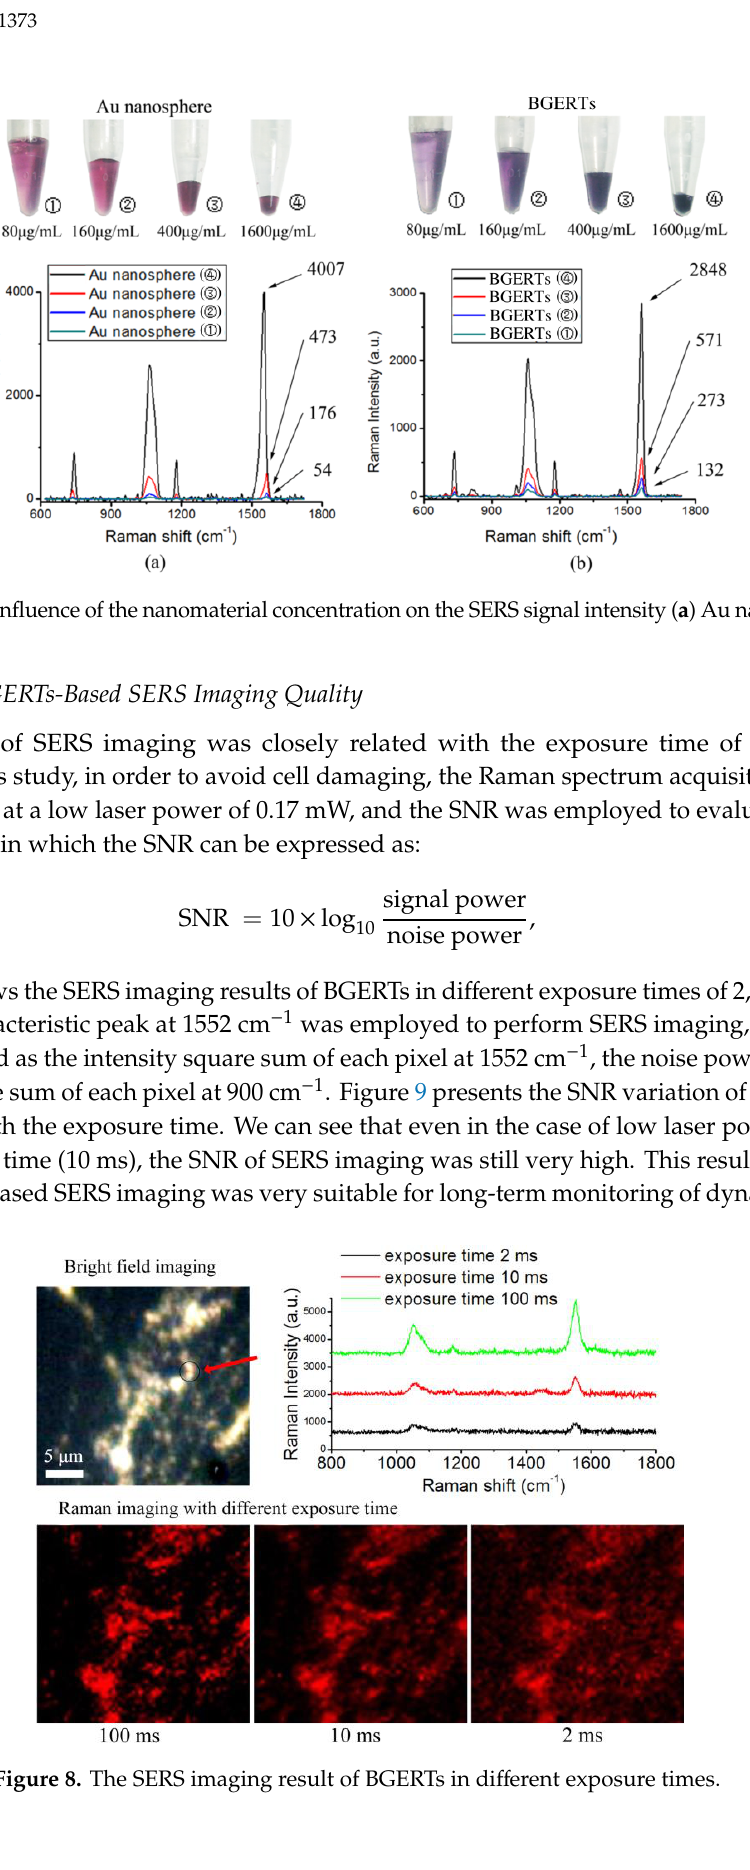
Figure 9. The signal-to-noise ratio (SNR) variation of BGERTs-based SERS imaging in different exposure times.